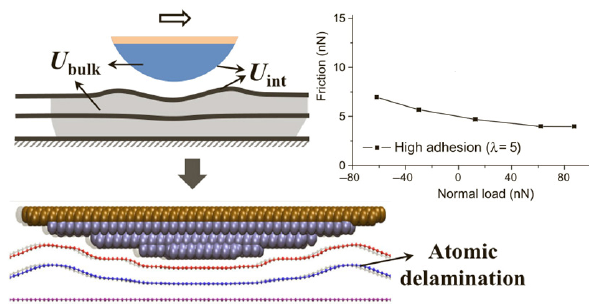
Fig. 5 Local atomic delamination of graphene and abnormal variation of friction with a normal load. Reproduced with permission from Ref. [86], © Springer Nature